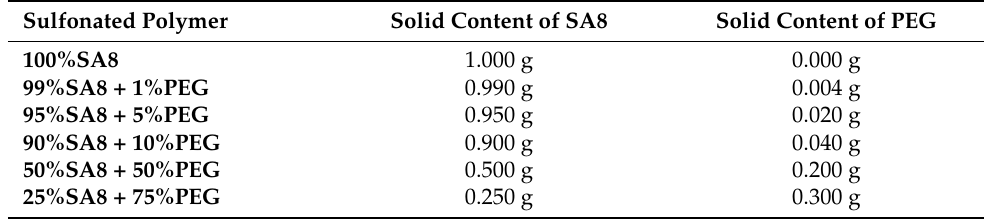
Table 1. Solid contents of SA8 and PEG.